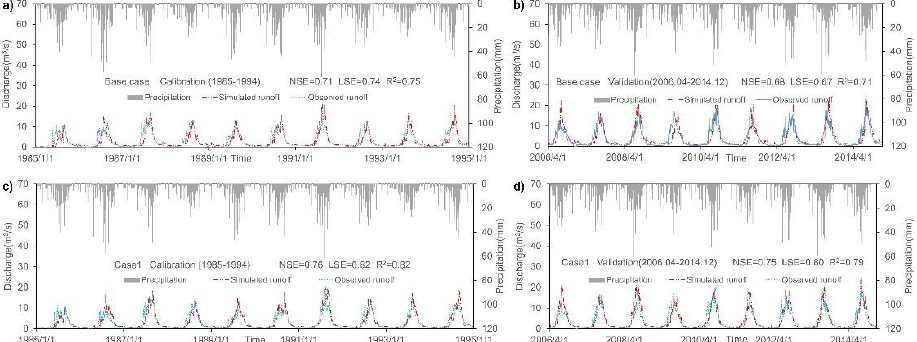
Figure 7. Comparison of daily runoff simulation results from the J2000 model using the traditional TLR scheme (Base Case, a and b) and the new TLR scheme (Case 1, c and d) for the periods of calibration (a and c) and validation (b and d).